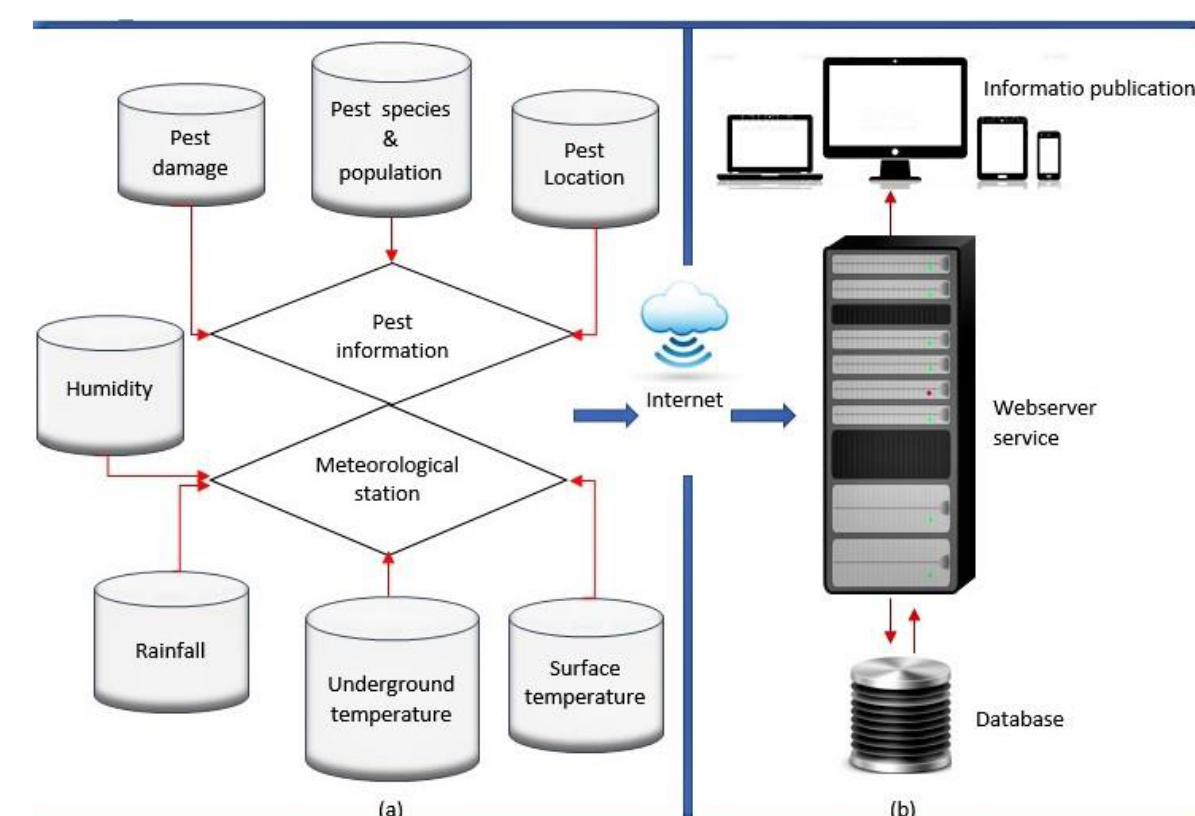
Figure 2. The components of the insect pest monitoring platform. ( a ) System for information collection, and ( b ) System for information analysis and display (adapted from [43]).